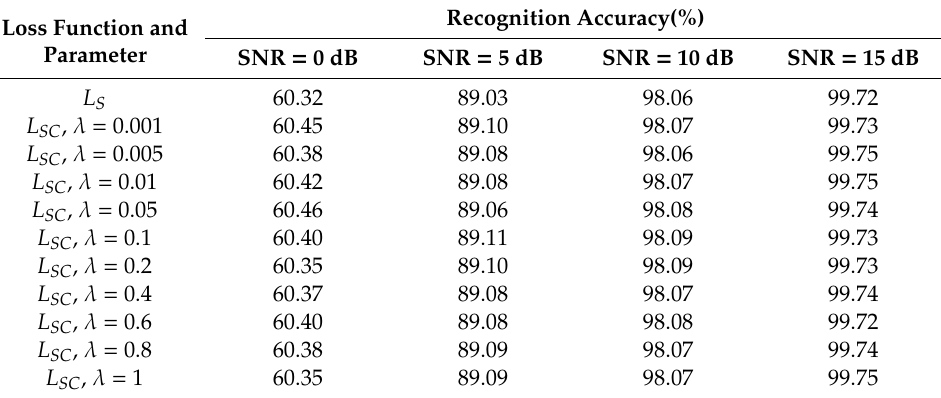
Table 2. Recognition accuracy of model A when the λ in loss function L SC is di ff erent while the dataset is under di ff erent SNR